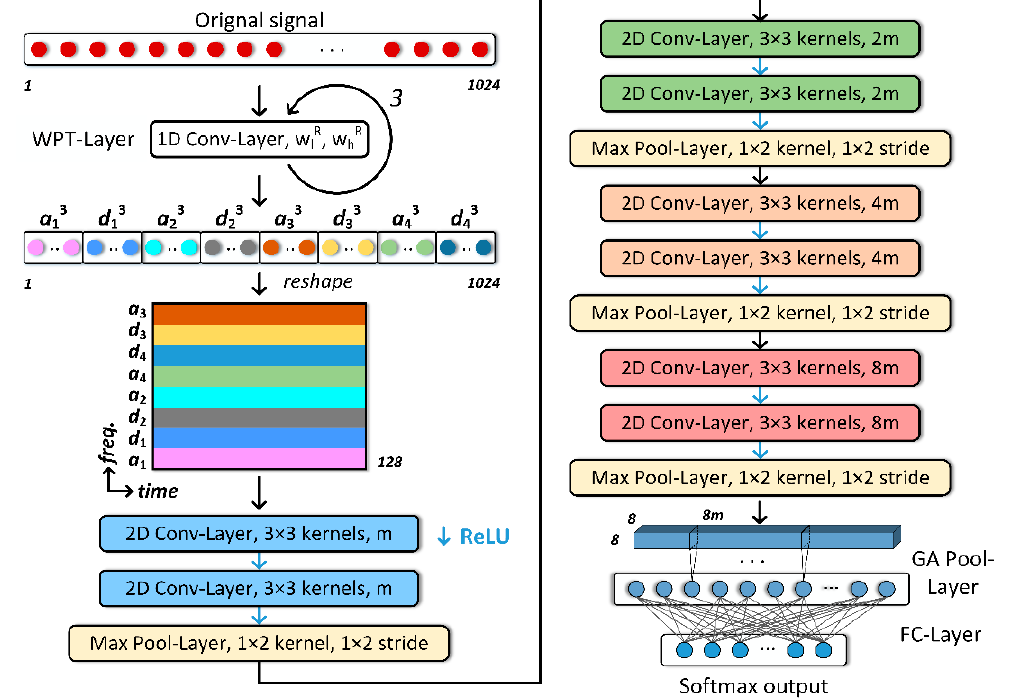
Figure 5. Proposed WPT-CNN architecture (example for 1024 data points of input signal and three levels of WPT).